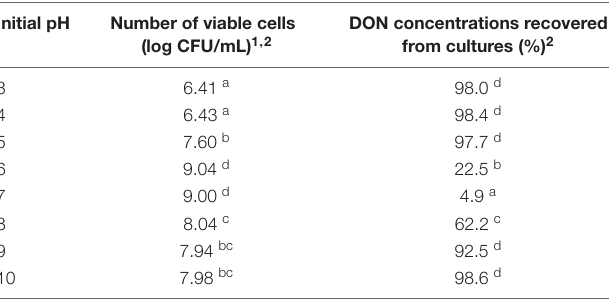
TABLE 2 | The growth and biotransformation of DON 1 by isolate 17-2-E-8 at selected initial media pH values. Initial pH